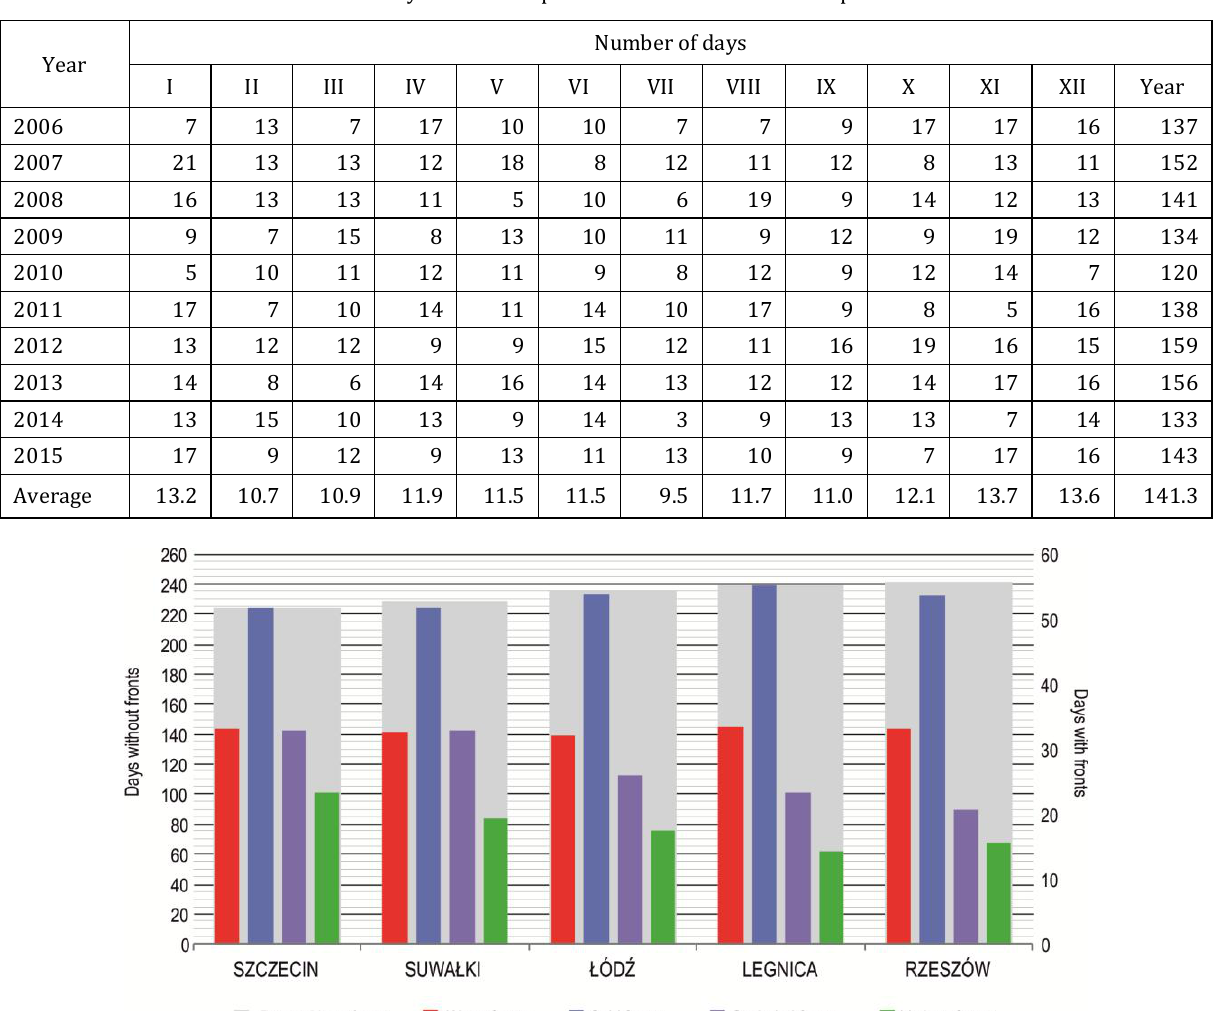
Table 2. Number of days with atmospheric fronts in Szczecin in the period 2006-2015